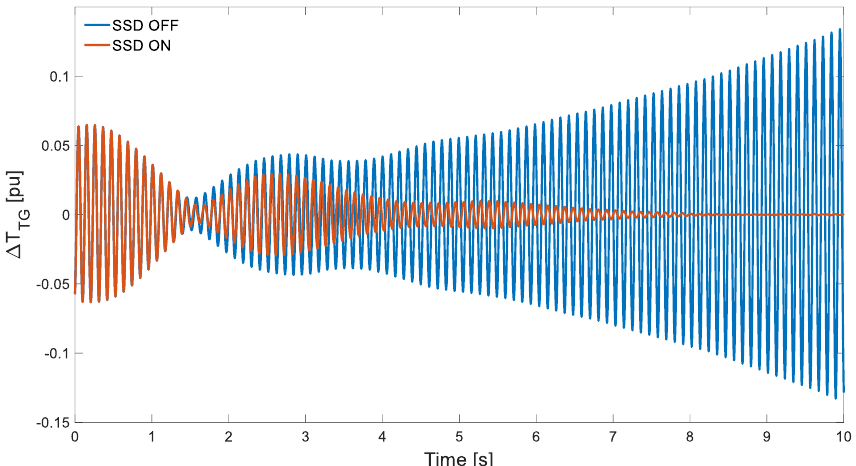
Figure 14. Torque oscillation ∆ T TG at the first TNF in configuration CD (results related to the data of